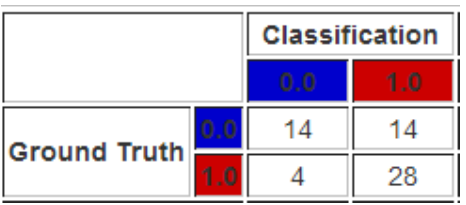
Figure 11. Confusion matrix for the Musk1 dataset for classification results after using the initial classification model. Blue color represents the negative class, and the red color represents the positive